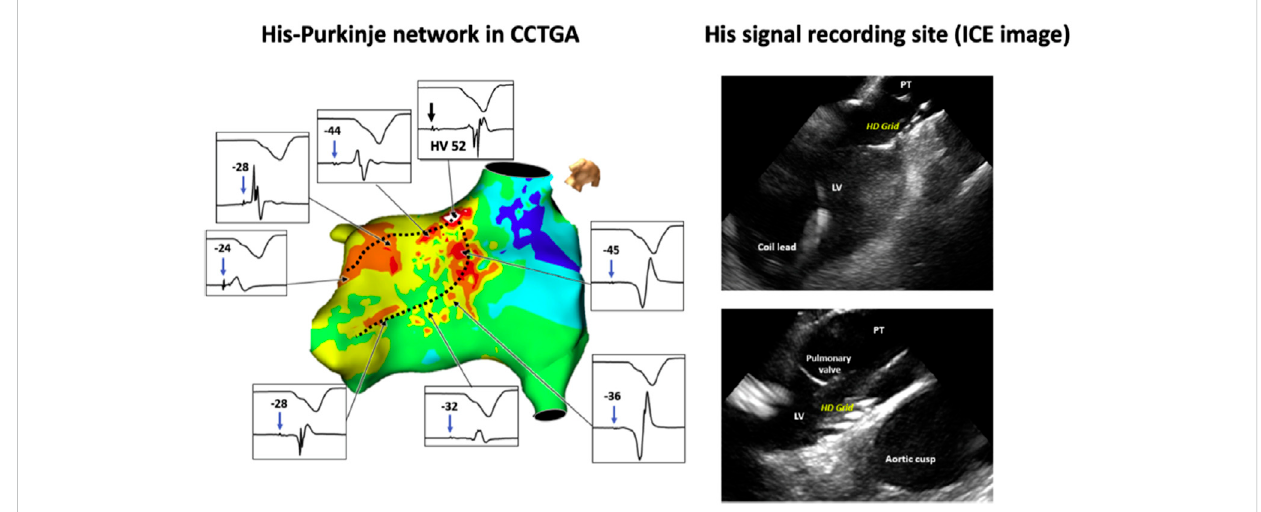
FIGURE 3 Left:Three-dimensionalmappingoftheconductionsystemincongenitallycorrectedtranspositionofthegreatarteries(CCTGA).Dashedblacklines indicatethecourseofthemorphologicleftbundlebranches.TheseptalaspectoftheHisbundleislocatedbelowtheleftventricularout fl owtract.Dueto theanomalousHis bundle course, thebundleenters theseptum awayfrom themitral annulus. Right: Multipolar mapping catheter against theventricular septum below the pulmonary valve annulus, where distal His-bundle electrograms were encountered. Intracardiac echocardiography (ICE) is used to demonstrate the position of the high-density multipolar catheter as it records His-bundle electrograms near the left ventricular out fl ow tract and pulmonary valve. LV = left ventricle; PT = pulmonary trunk. Reproduced with permission, Moore et al.